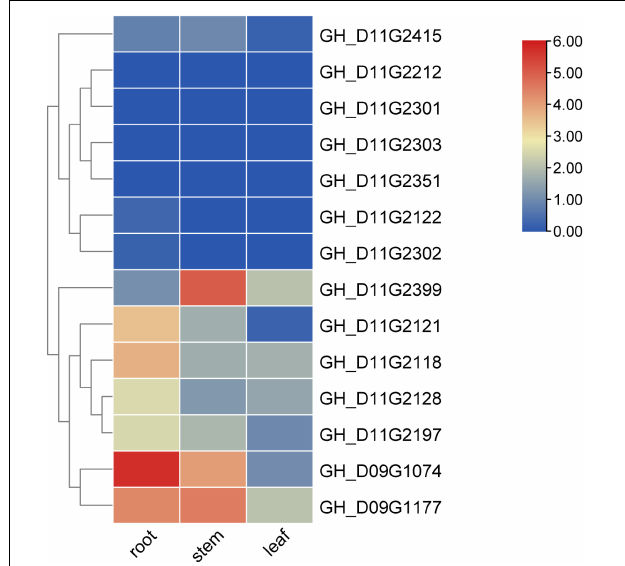
FIGURE 5 | Expression information of candidate genes in TM-1. The value shown in the heatmap is log 2 (1+RPKM) based on RNA-seq data of TM-1. The data are the original expression data in the expression